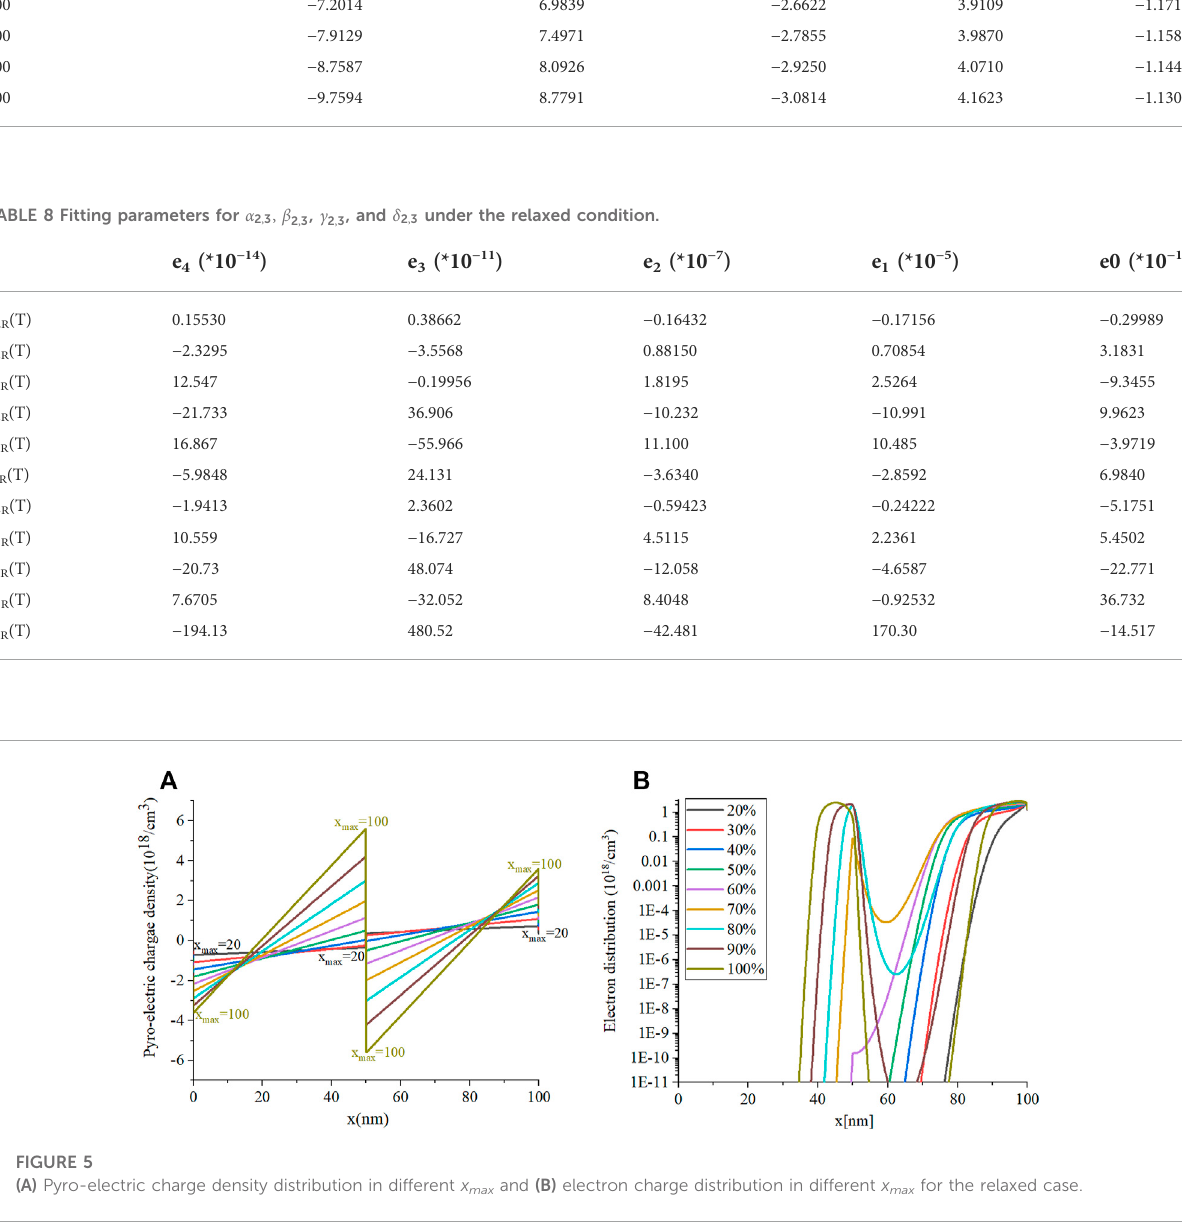
Figure 6A showsboththeelectronandholeconcentrationforthe x max = 100% case. Here, the p-n-p-n-type structure can be seen; however, the hole concentration between ~60 and ~80 nm has effectively compensated the free electrons leaving the material with